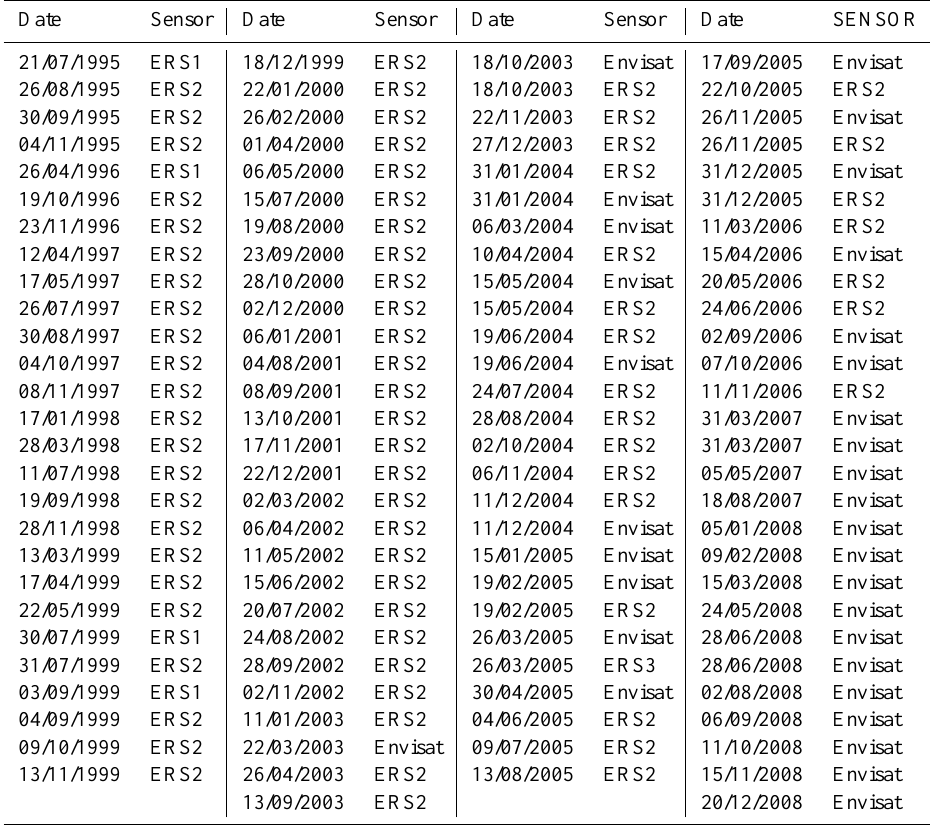
Table B1. List of processed SAR